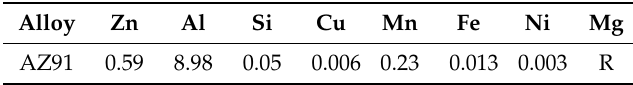
Table 1. Chemical composition of the investigated alloy